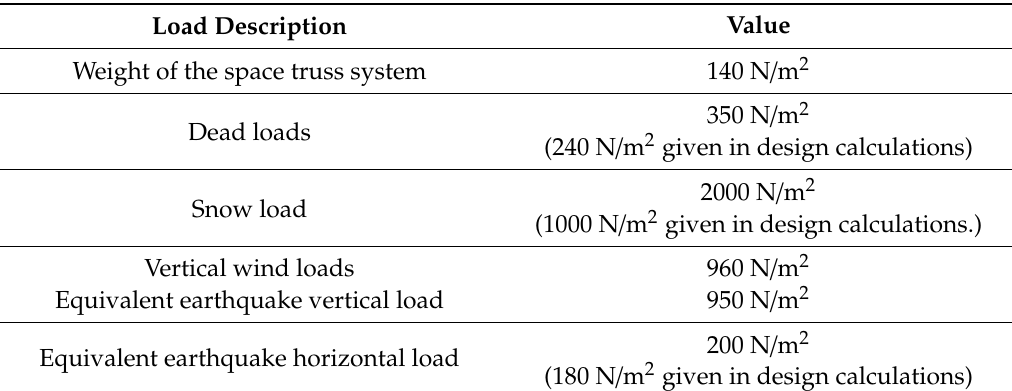
Table 2. The loads considered in the